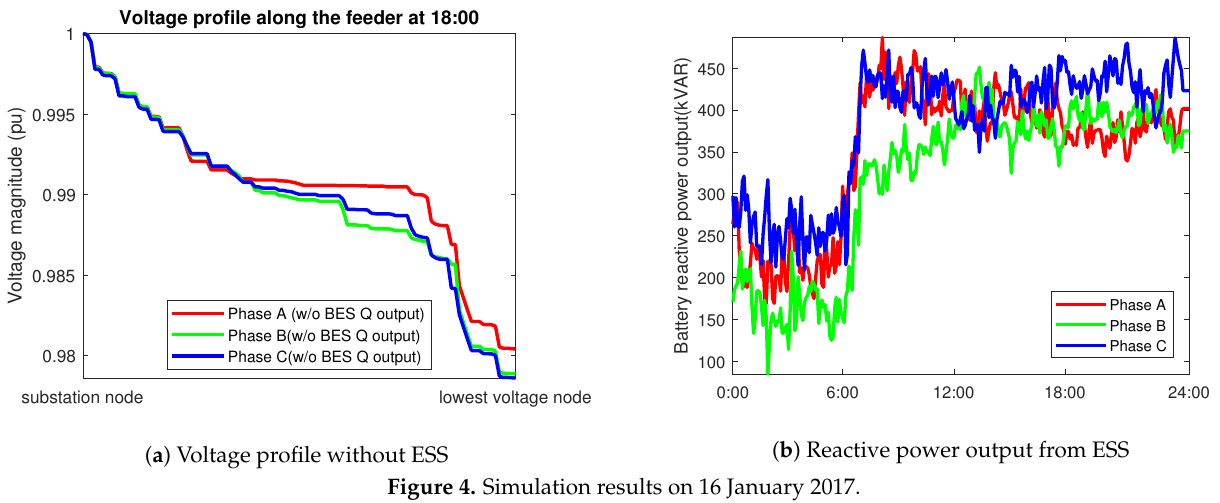
Figure 4. Simulation results on 16 January 2017.